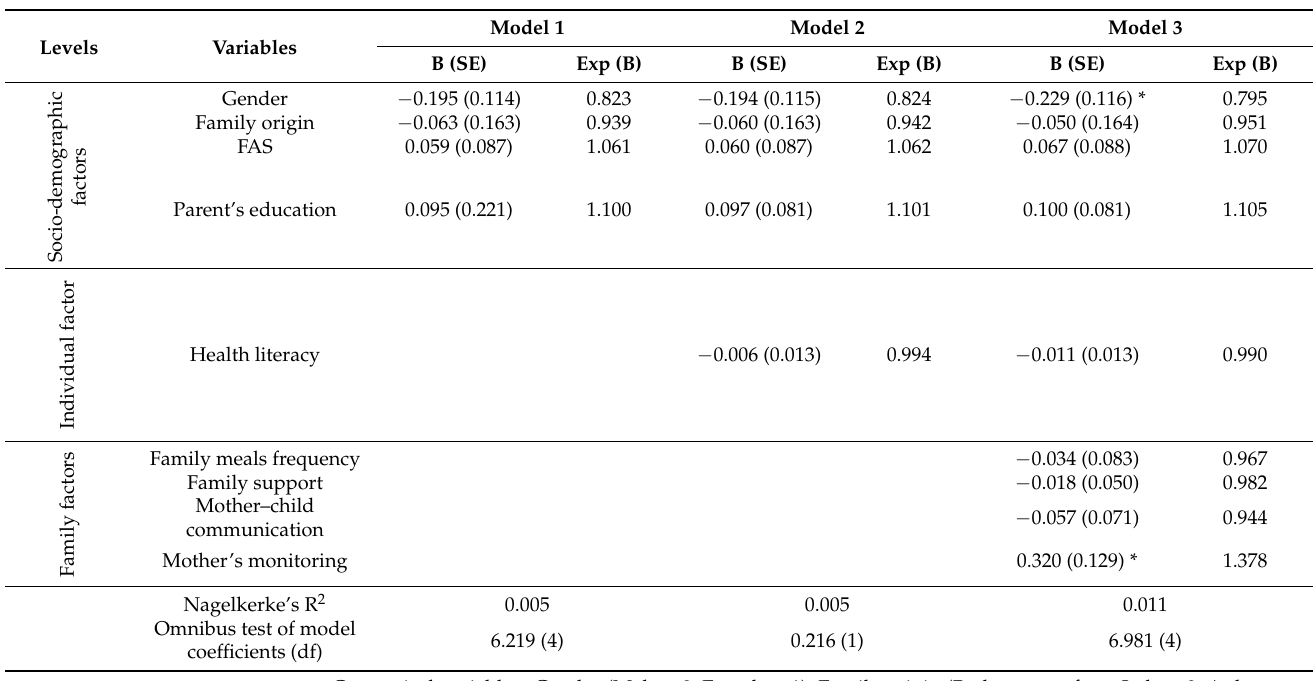
Table 5. Results of multiple binary logistic regression models predicting sweets consumption.